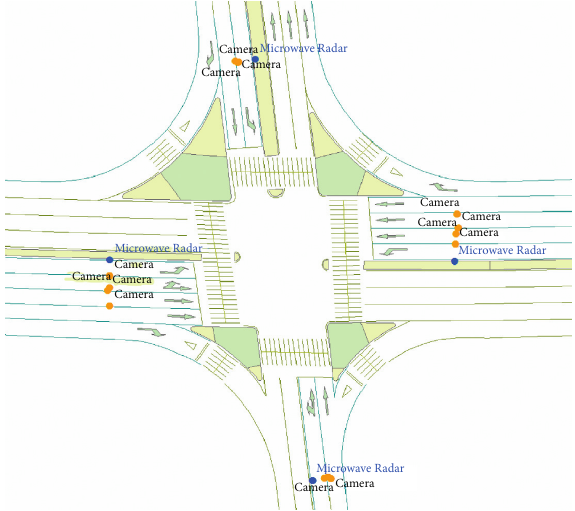
Figure 1: Intersection plan. Table 1: Introduction of the source